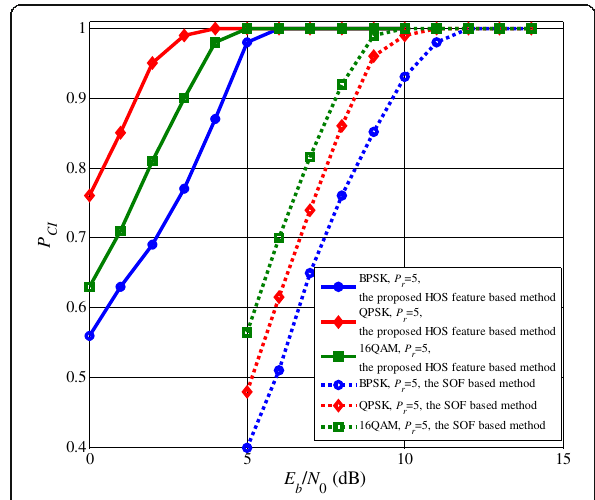
Fig. 7 The performance comparison between the proposed HOS feature-based method and the SOF-based